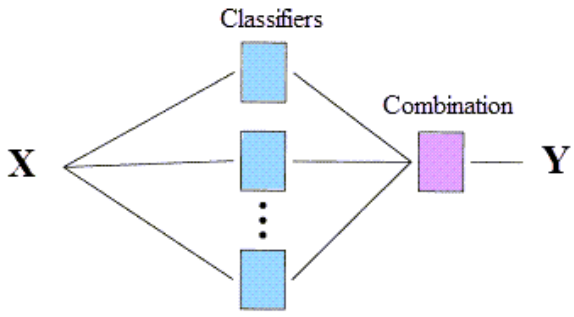
Figure 1. A general structure of an EL approach.